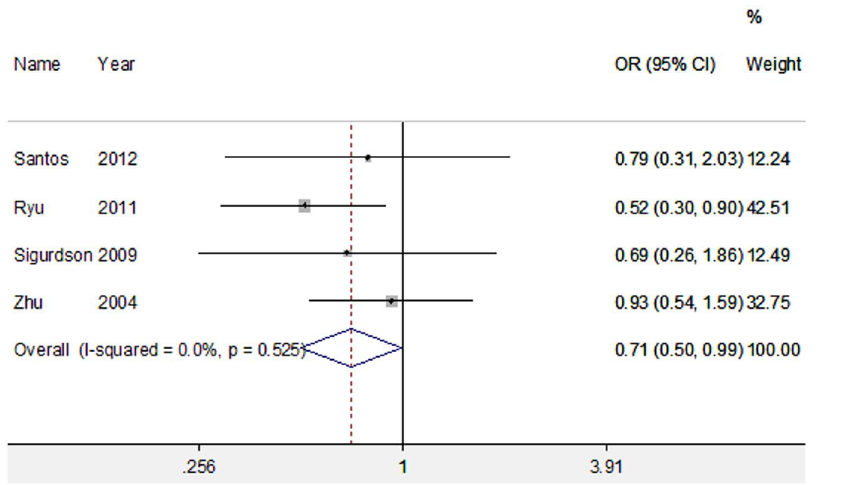
Figure 3. Forest plot of ORs with 95% CI for XRCC1 Arg194Trp polymorphism and the risk of PTC under dominant model. The center of each square represents the OR, the area of the square is the number of sample and thus the weight used in the meta-analysis, and the horizontal line indicates the 95%CI. His/His vs. Arg/Arg, P = 0.992 for Arg/His vs. Arg/Arg, P = 0.656 for dominant model, P =0.236 for recessive model and P = 0.821 for additive model), respectively.